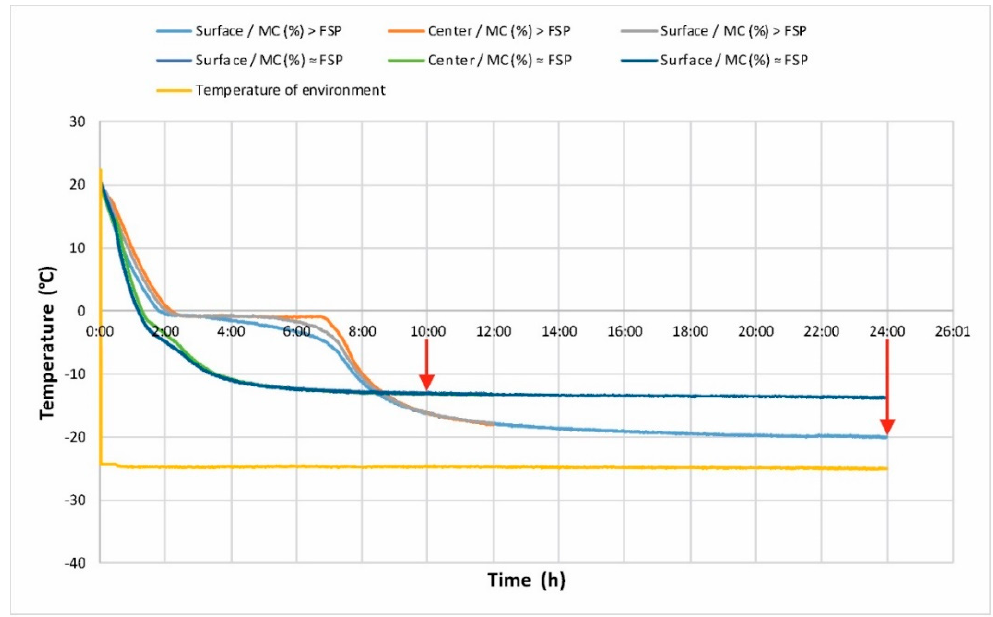
Figure 2. Temperatures of sample in the cross-section and the temperature of the environment depending on time (freez- ing process).